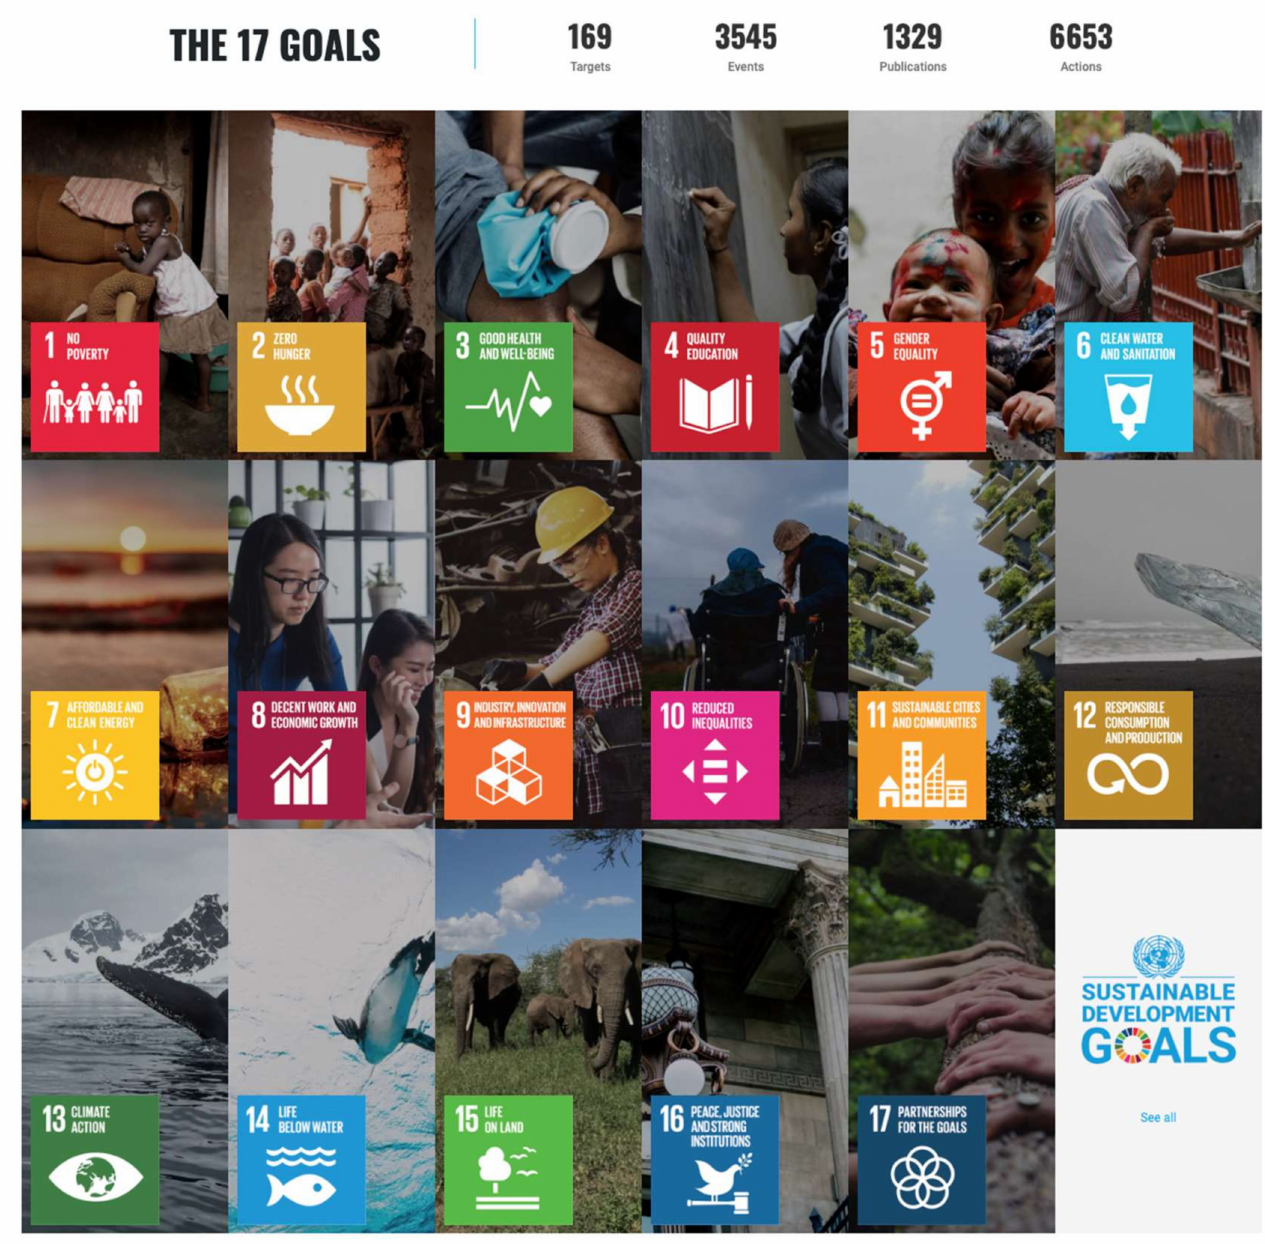
Figure 3. UN SGDs. Source https://sdgs.un.org/goals (accessed on 10 December